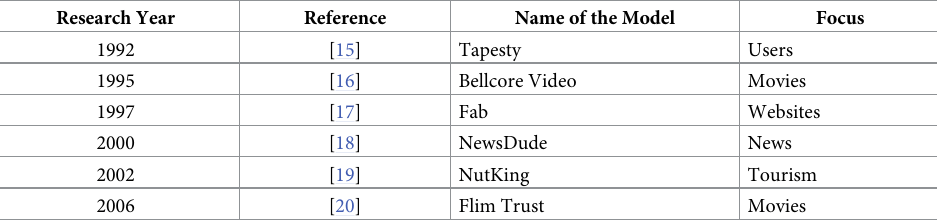
Table 1. Breakthroughs for certain CFL approaches and their